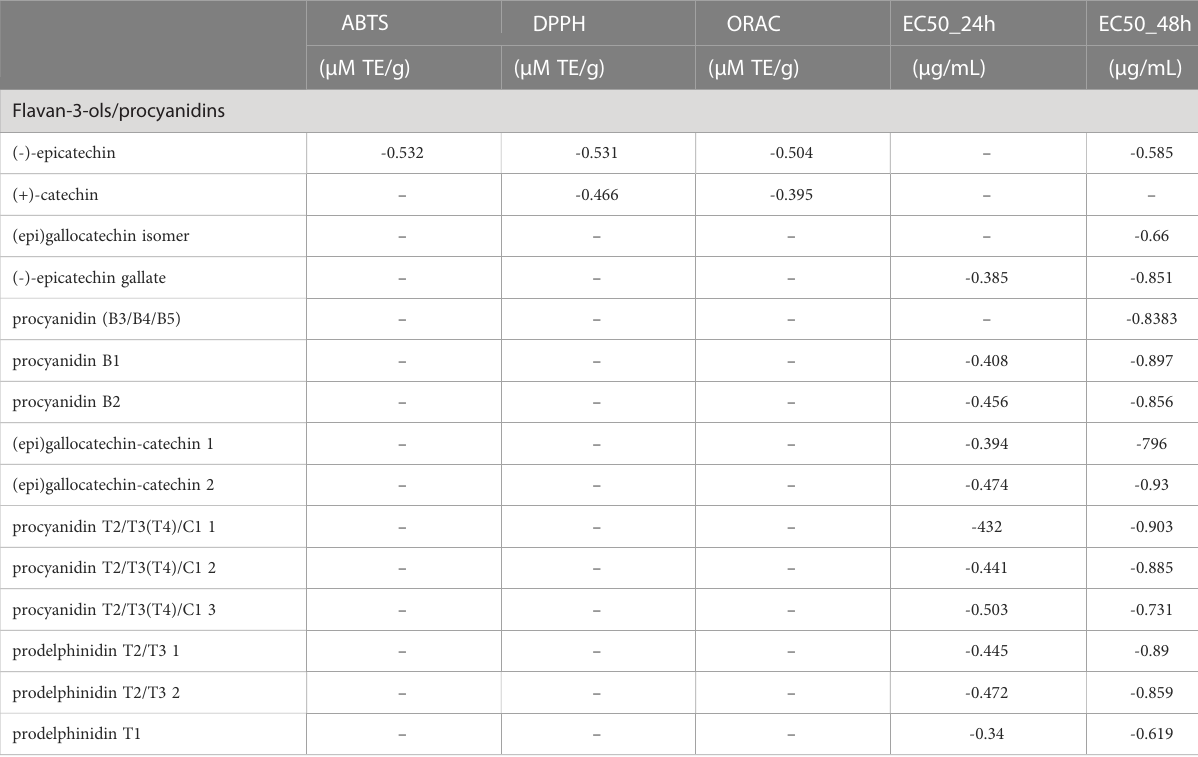
TABLE 4 Pearson ’ s correlation coef fi cients of fl avan-3-ols/procyanidins, antioxidant activity (ABTS, DPPH, ORAC) and median concentration of antiproliferative activity (EC50 after 24h and EC50 after 48h).